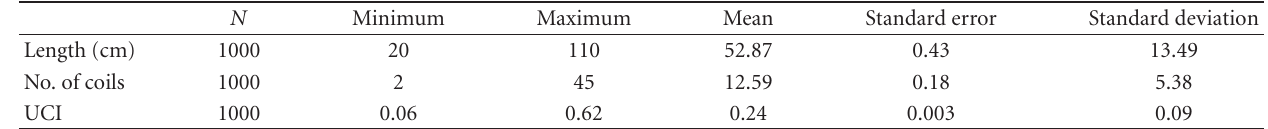
Table 1: Umbilical coil characteristics.